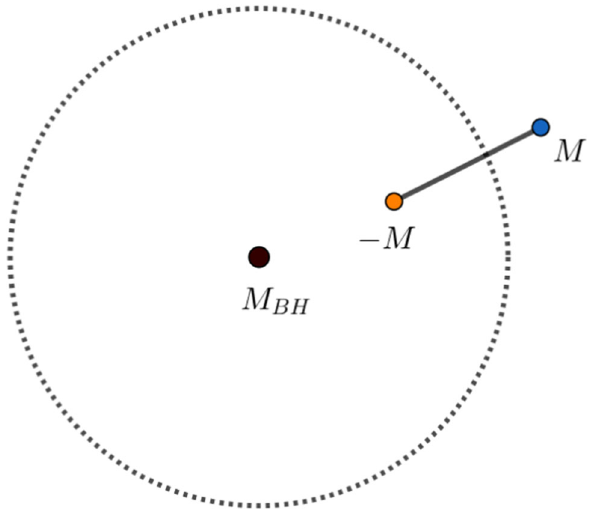
Fig. 3 Pair of entangled particles, one inside and the other outside the horizon